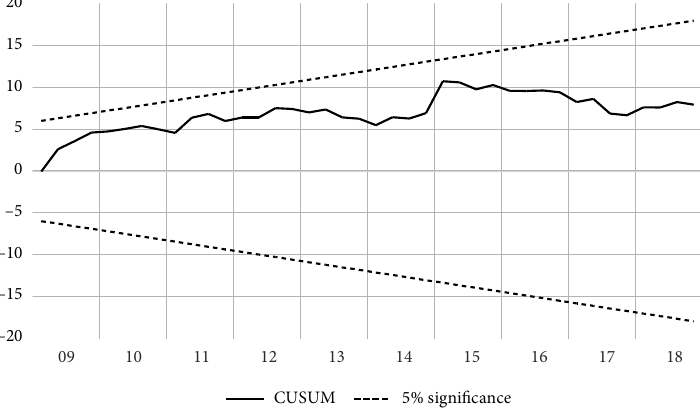
Figure 5. CUSUM of the multivariate estimation